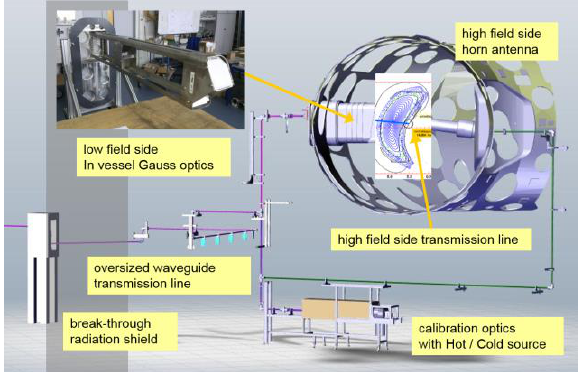
Fig. 3: Scheme of the overall transmission line system. The additional transmission line for O-mode radiation